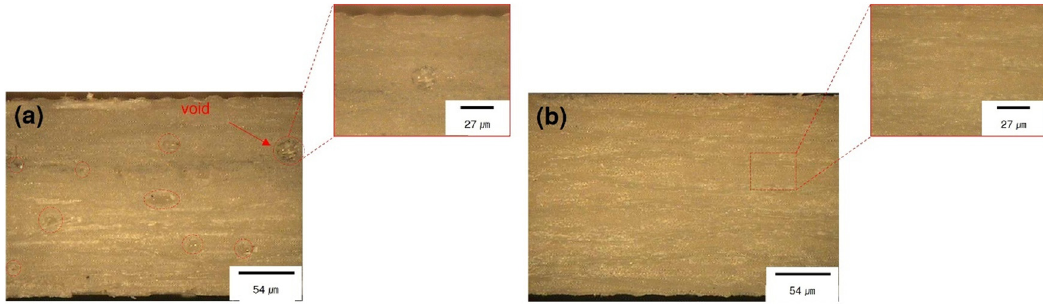
Figure 6: Comparison of specimen cross - sections according to ( a ) Case 1 and ( b ) Case